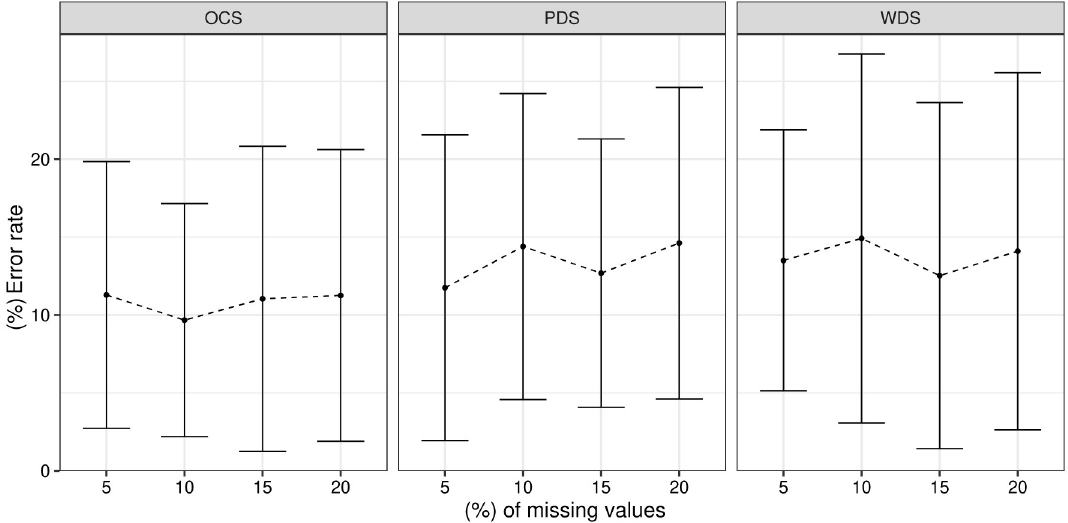
Fig 4. Average error rates after 100 repetitions for the Iris Plant dataset.